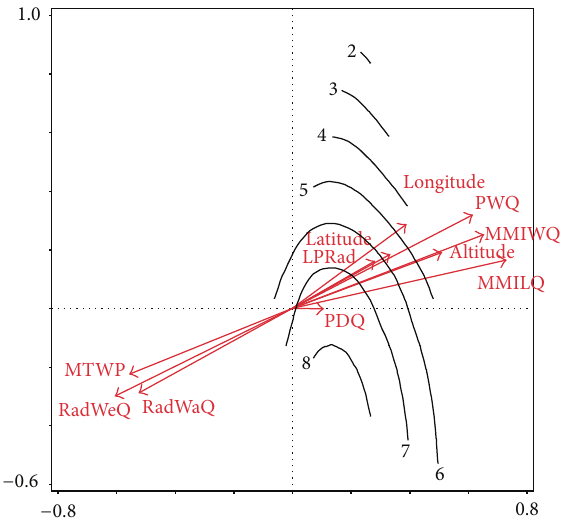
Figure 2: Generalised Additive Model based contour plot for tree hollow number per plot against the 11 most significant environ- mental variables (minimum of 0.5% contribution) within the CCA model. Codes given in Table 3. Axes represent the first two axes of CCA analysis.